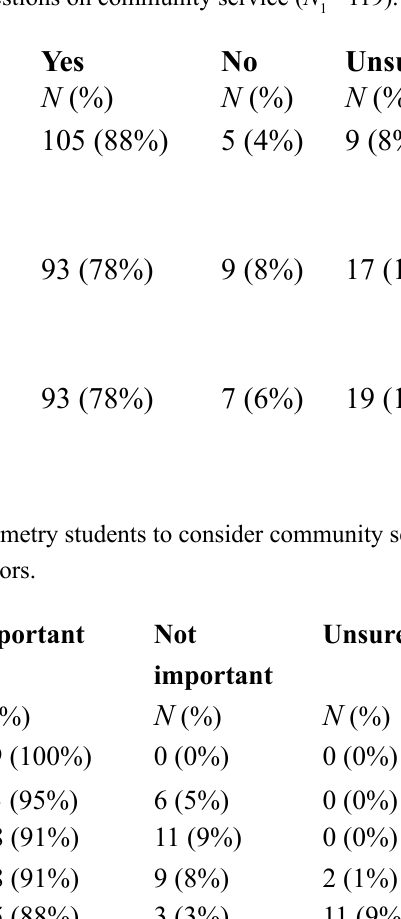
Table 1 : Percentage of participants who responded to the listed questions on community service ( N